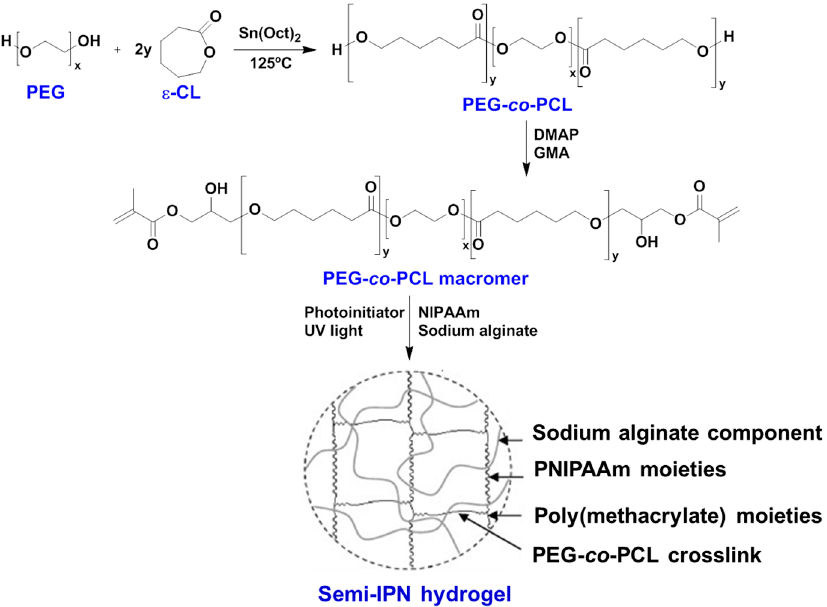
Figure 18. Scheme of the copolymerization reaction between ethylene glycol (EG) and ε -caprolactone ( ε -CL) with glycidyl methacrylate (GMA) end-groups and 4-dimethylaminopyridine (DMAP) catalyst, followed by UV irradiation to obtain the interpenetrating polymer network (IPN)-hydrogel with grafted sodium alginate polysaccharide. Adapted with permission from Reference [109]. Copyright © 2009 Elsevier Ltd. (Amsterdam, The Netherlands).